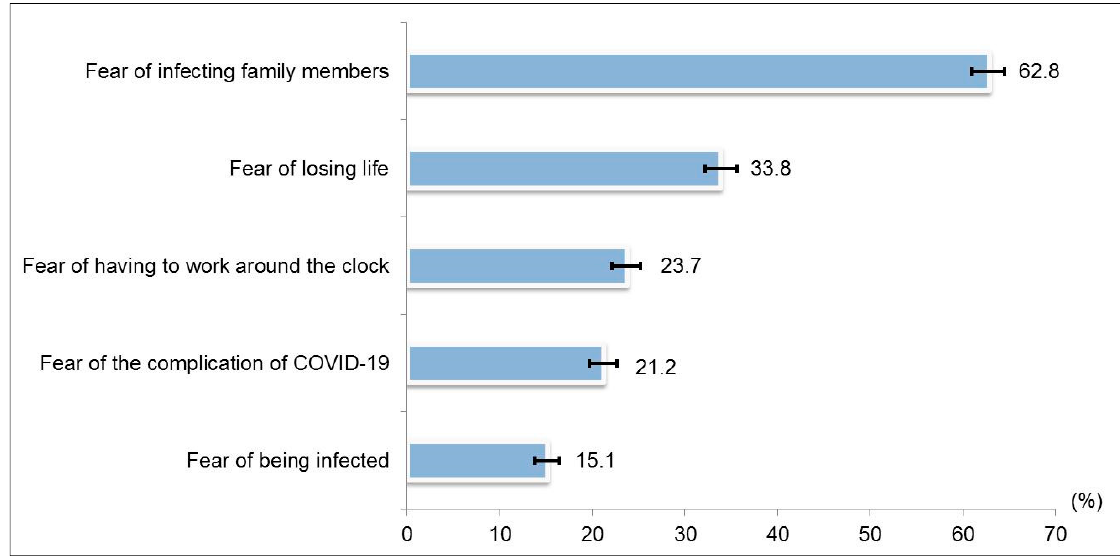
Figure 1. Proportion of ‘very afraid/moderately afraid’ responses for perceived fear items (N =